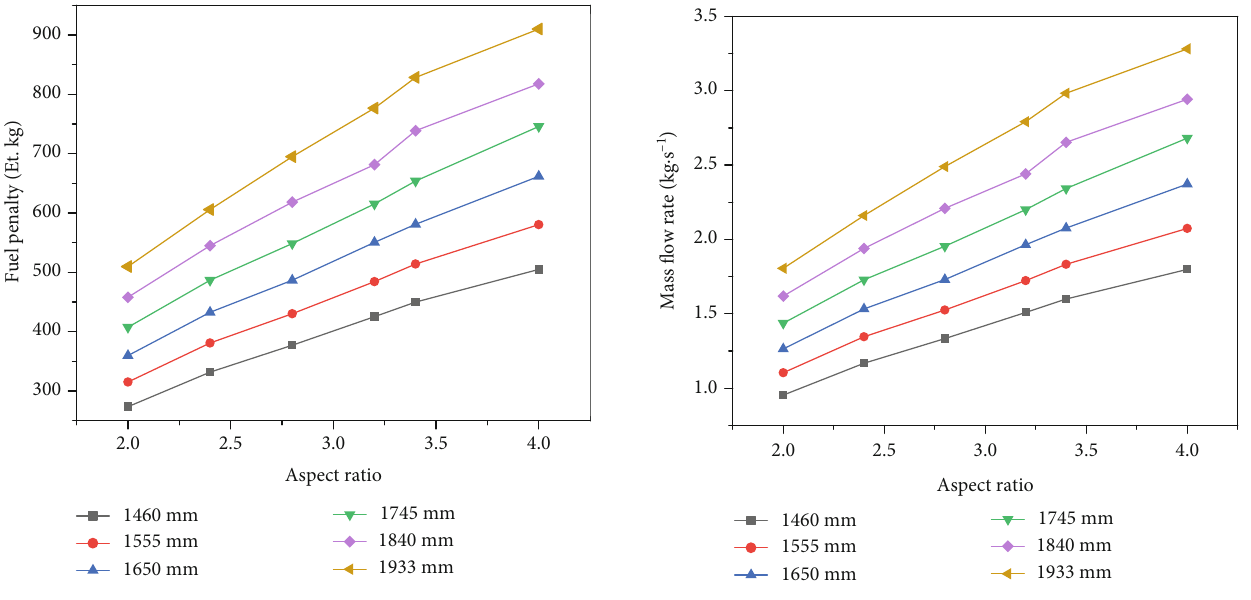
Figure 5: Mass fl ow rate with di ff erent aspect ratios and opening lengths at a slope angle of 6 ° .